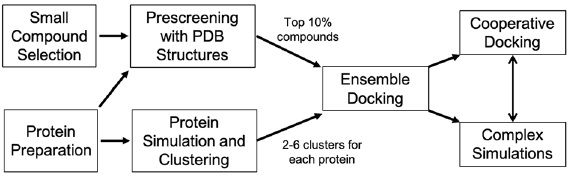
Figure 5. Cartoon illustration of our workflow. Prescreening used the Virtual Screening Wizard and ensemble/ cooperative docking was performed with Glide with the Glide XP scoring